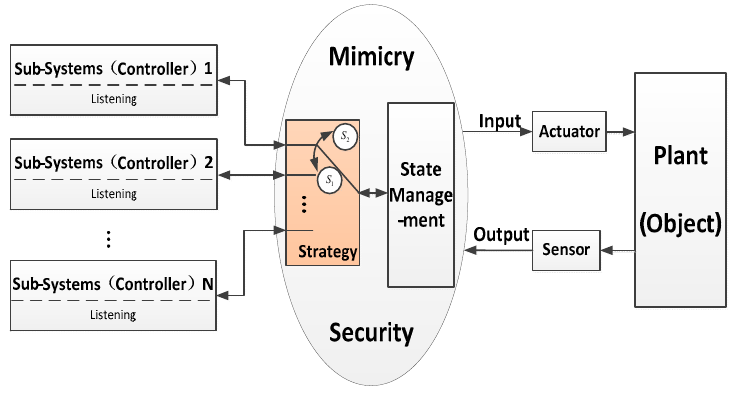
Figure 8. Mimicry security defense strategy.